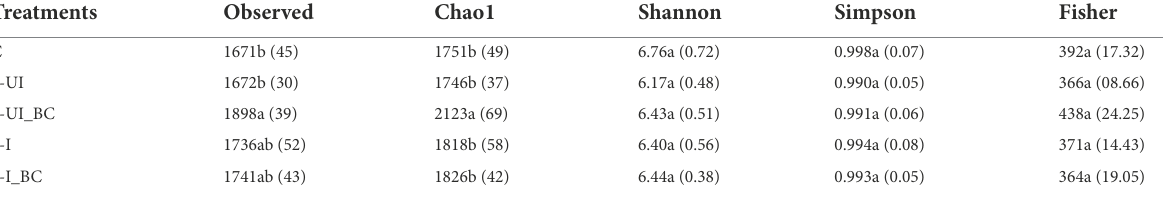
TABLE 3 Alpha diversity metrics of soil bacterial communities in different